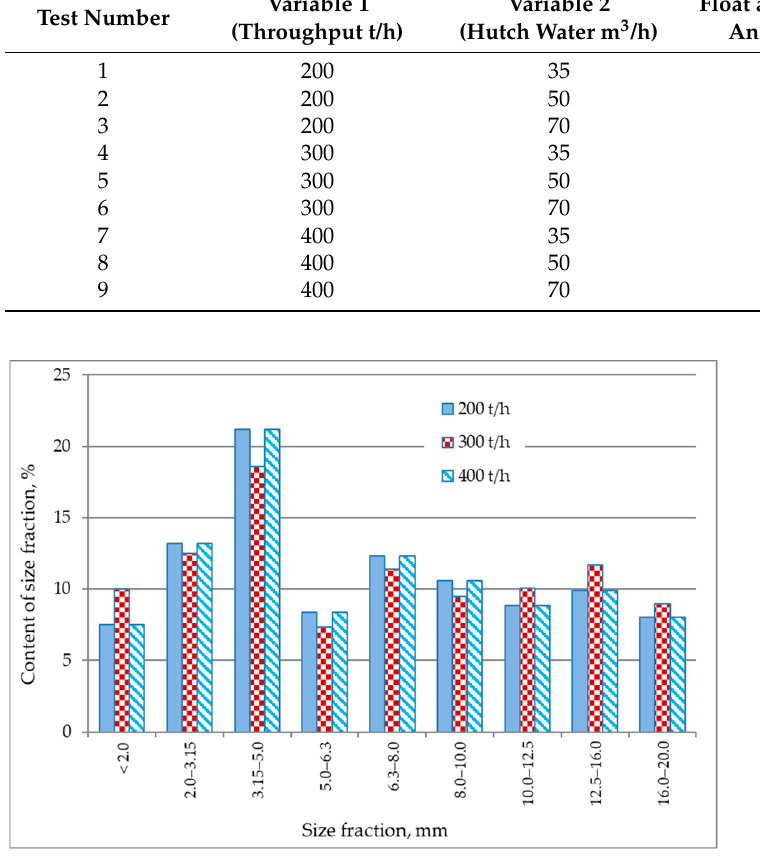
Figure 2. Particle size fractions in investigated coal plant for individual experiments.